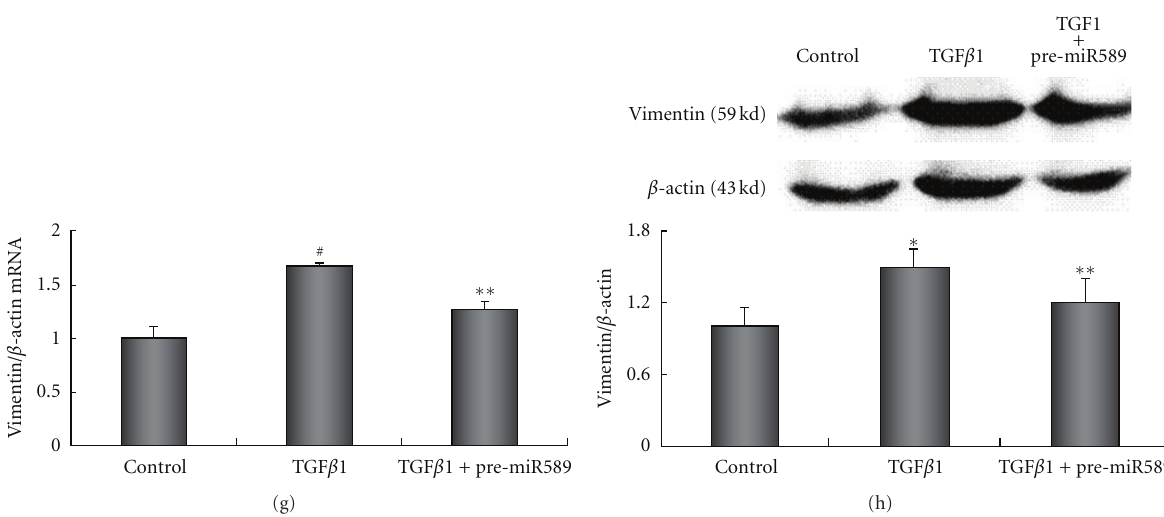
Figure 4: E ff ect of pre-miRNA589 on expression ZO-1, E-cadherin, and vimentin in HMrSV5 cells following exposure to TGF β 1(5 ng/ml, 24hr). Panel (a) and (b) showed the ZO-1 and vimentin protein expression detected by immunofluerence. Fluorescent confocal microscopy for ZO-1 and vimentin confirmed that pretreatment of pre-miR589 normalized the EMT changes induced by TGF β 1 in HMrSV5 cells. Panel (c) and (d) showed that TGF β 1 treatment led a reduction in the mRNA and protein expression of ZO-1 (Panel (c), column 2 and panel (d), column 2). These changes were attenuated by the overexpression of miRNA589 with treatment of pre-miRNA589 (Panel (c), column 3 and panel (d), column 3). The pre-miRNA589 partially reversed the TGF β 1-induced mRNA and protein expression of E-cadherin changes as well as ZO-1 (Panel (e), columns 2 and 3, and panel (f), columns 2 and 3). The level of ZO-1and E-cadherin was decreased, while the level of vimentin mRNA as well as protein were increased in HMrSV5 cells treated with TGF β 1(5ng/ml, 24hr) (Panel (g), column 2 and panel (h), column 2), and this e ff ect was abolished following the transfection with pre-miRNA589 (Panel (g), column 3, and panel (h) column 3). ∗ P < 0.05. versus control group, ∗∗ P < 0.05 versus TGF- β 1 treated group. # P < 0.01 versus control group. ## P < 0.01 versus TGF- β 1 treated